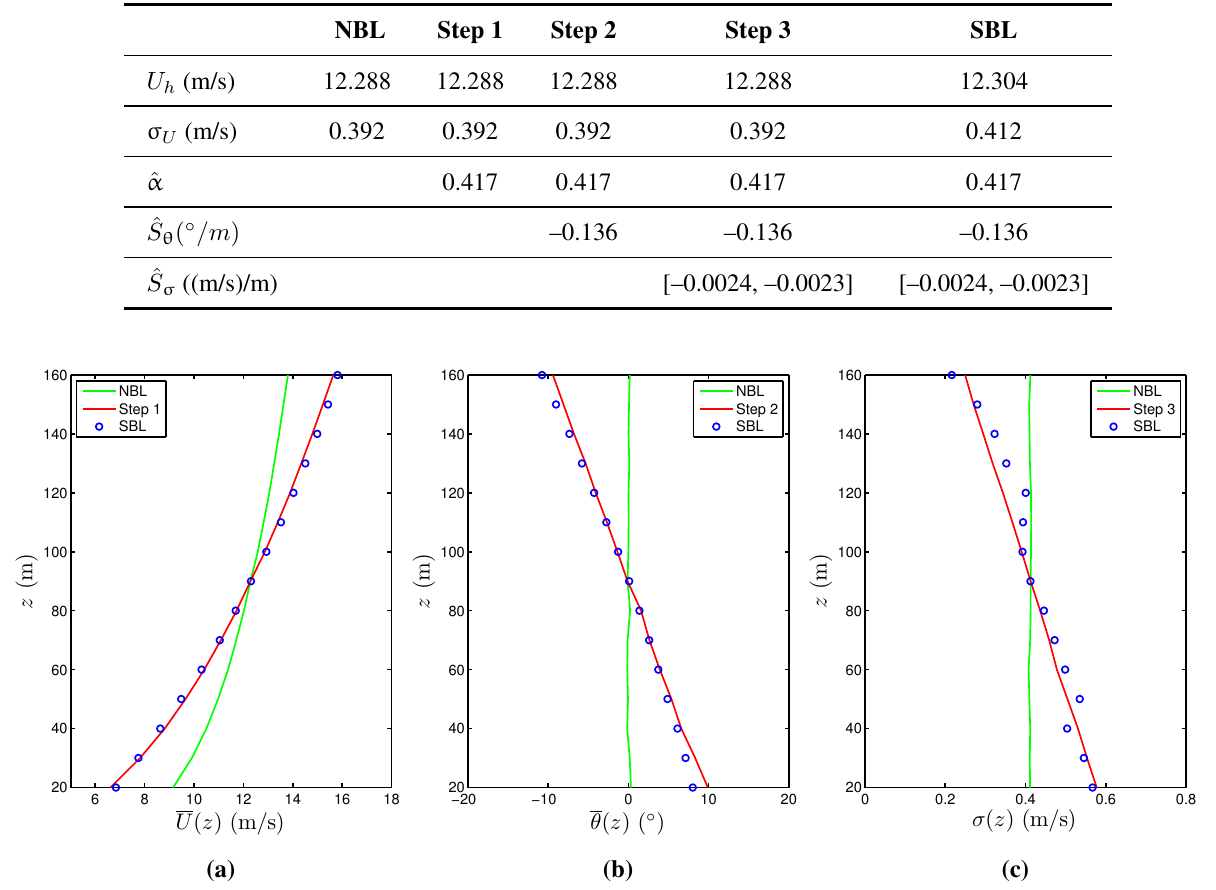
Table 2. Step-wise adjustments of vertical profiles for mean wind speed, mean wind direction, and turbulence standard deviation for a single LES run (taken from the last hour of a 12-hour simulation for the control case in Table 1).